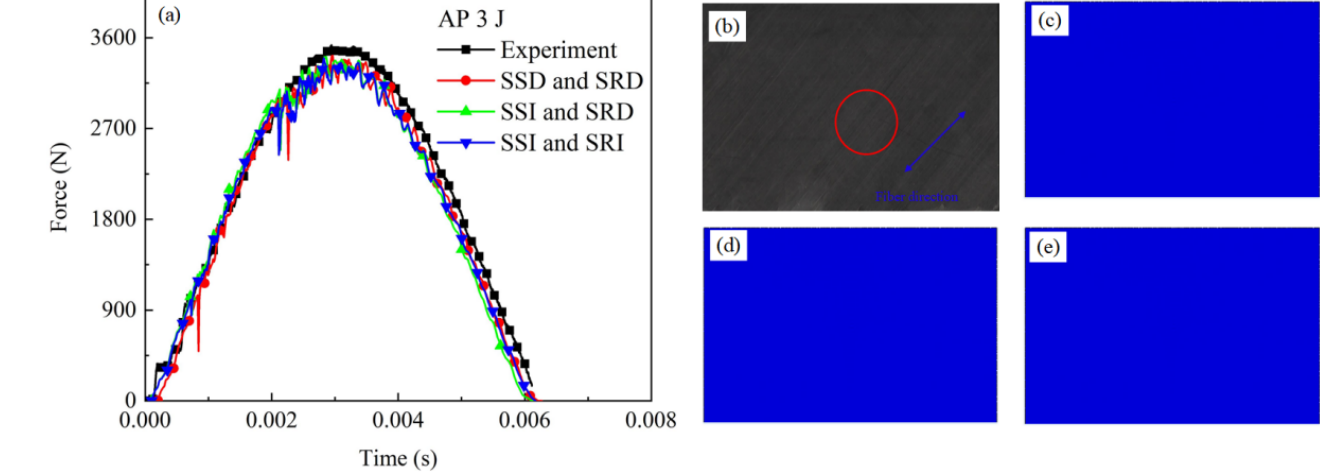
Figure 7. Comparison of experimental results and simulation results ( a ) contact force; ( b ) experimental failure pattern; ( c ) SSD and SRD ( d ) SSI and SRD ( e ) SSI and SRI simulation result.